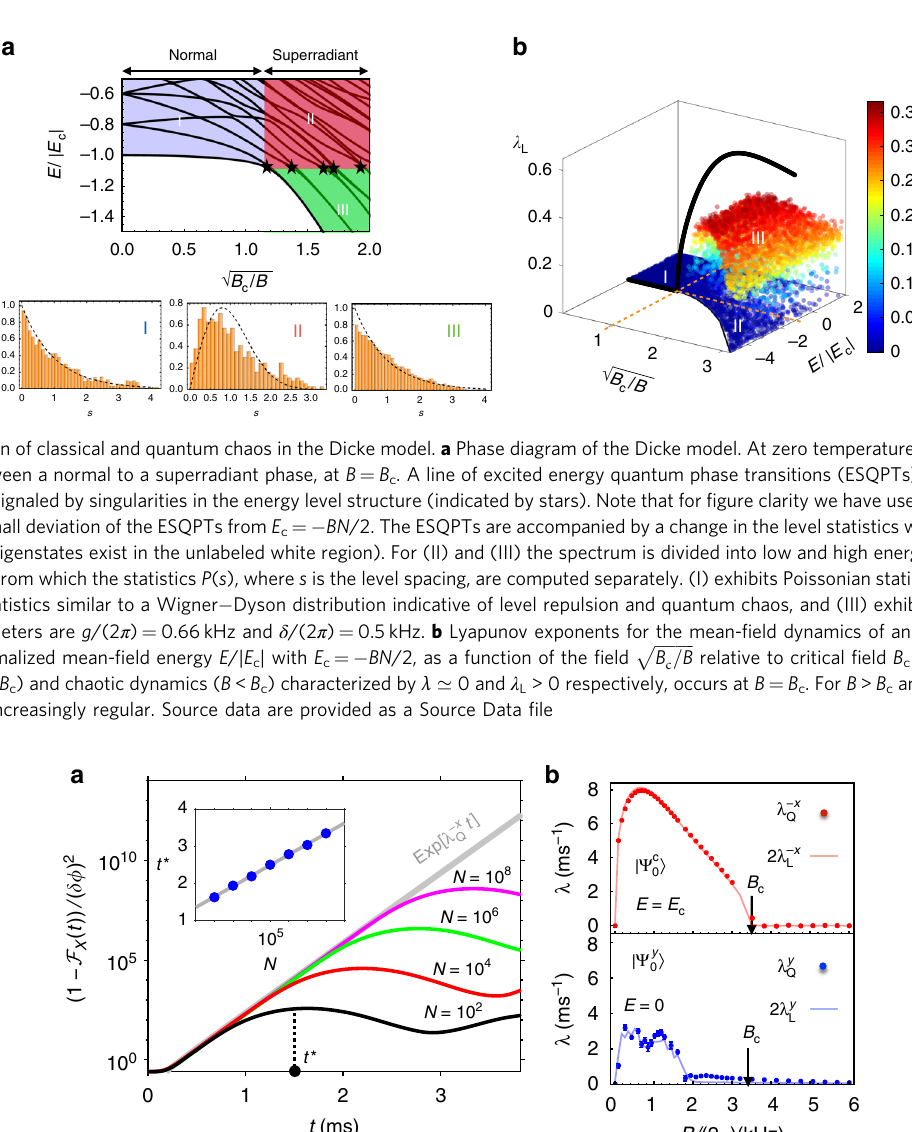
i ¼ Fig. 3 Signatures of classical chaos in quantum FOTOCs. a Initial exponential growth of the FOTOC, ½ 1 (cid:2) F X ð t Þ(cid:3) = ð δϕ Þ 2 and the initial state j Ψ c 0 jð(cid:2) N = 2 Þ i (cid:5) j 0 i (see Supplementary Note 1 for examples of exponential growth in other states). We assume δϕ (cid:6) 1 = N such that we may equivalently use x ^ X Þ ’ ½ 1 (cid:2) F ð t Þ(cid:3) = ð δϕ Þ 2 for the plotted data. The scrambling time t * is de fi ned by the saturation of the FOTOC, which we extract from the fi rst var ð X þ log ð N Þ = λ maximum and plot in the inset (blue data). We fi nd t (cid:7) (cid:4) a with a 0 a fi t parameter (gray line). b Lyapunov exponent, λ , as a function of 0 Q transverse fi eld: Quantum λ Q (red markers) and classical 2 λ L (solid lines). Superscript notation of the exponents denotes the initial polarization of the i , the same state as ( a ), and bottom for j Ψ y i (cid:8) jð(cid:2) N = 2 Þ i (cid:5) j 0 i , here N = 10 4 particles. In both plots we chosen coherent spin state. Top panel for j Ψ c 0 y 0 ’ 2 λ observe λ . Error bars for λ Q are a 95% con fi dence interval from an exponential fi tted to the numerical data. Coupling g and detuning δ are same as Q L Fig. 2. In ( a ) B /(2 π ) = 0.7 kHz ( B / B c = 0.2). Source data are provided as a Source Data fi is neither Wigner − Dyson nor Poissonian P P ( s ) = exp( − s ). The